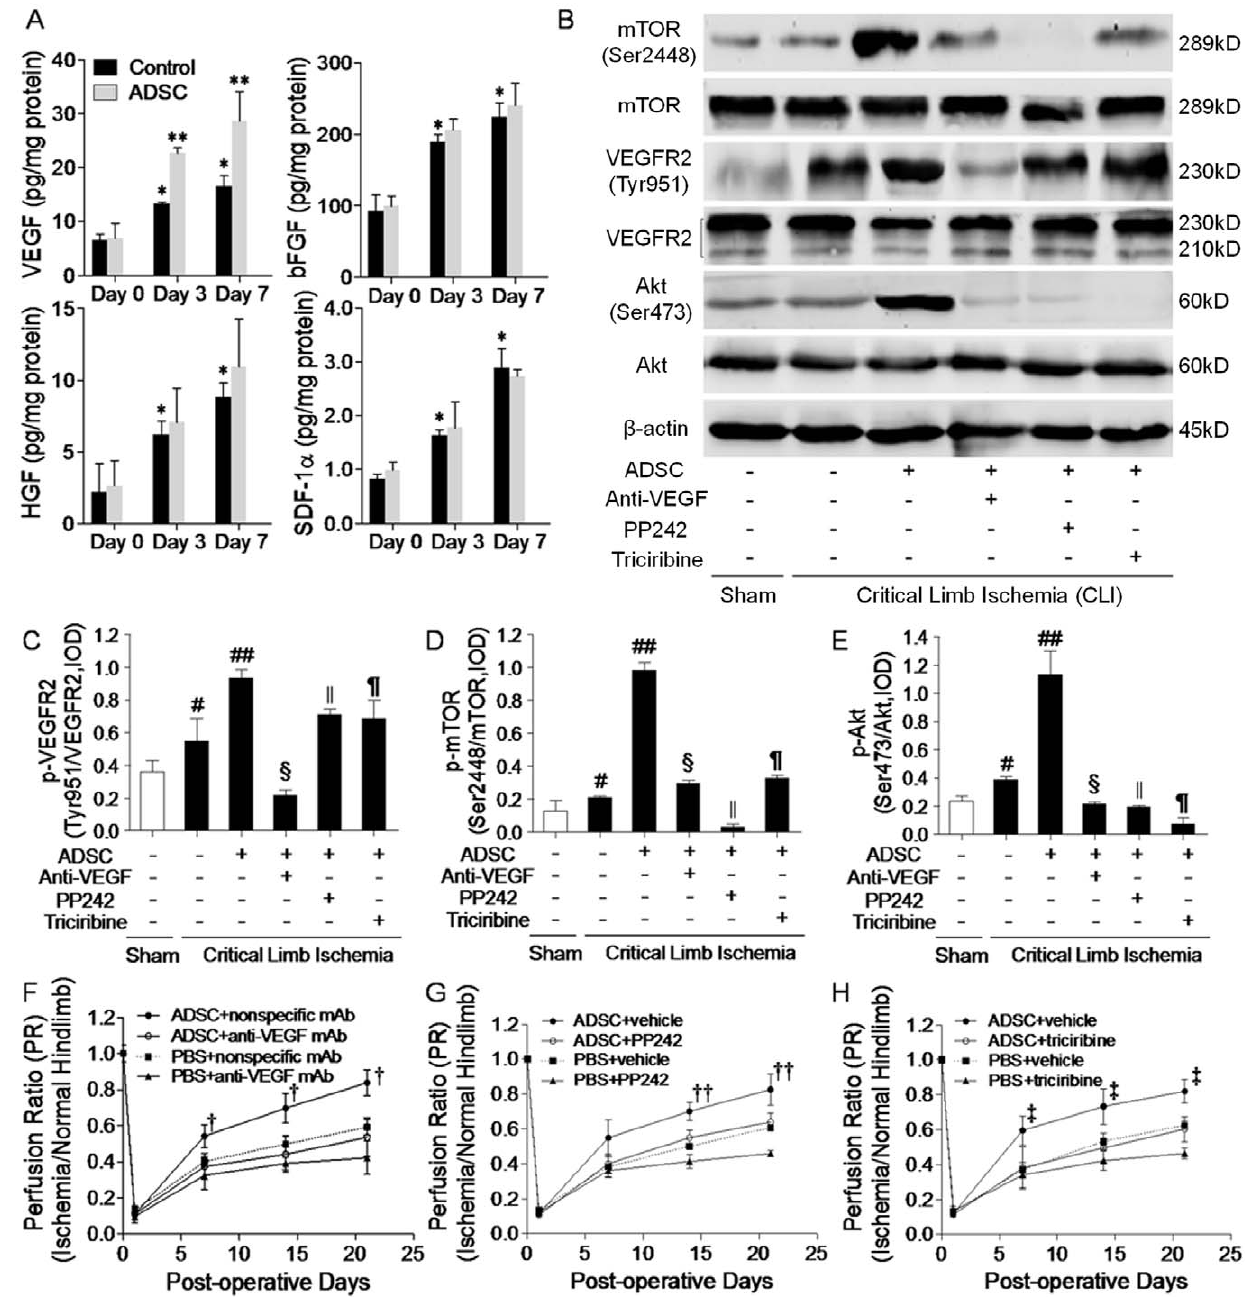
Figure 7. Transplanted mADSCs activated VEGF/mTOR/Akt pathway invivo . Levels of vascular endothelial growth factor (VEGF), basic fibroblast growth factor (bFGF), hepatocyte growth factor (HGF) and stromal cell derived factor-1 a (SDF-1 a ) in PBS or ADSC-treated ischemic hindlimbs on day 0 (baseline), 3 and 7 using ELISA ( a ). Western blot analysis ( b ) of VEGFR2(Tyr951)/VEGFR2 ( c ), mTOR(Ser2448)/mTOR ( d ), Akt(Ser473)/Akt ( e ) and b -actin expression within ischemic hindlimbs on day 7. Protein expression was quantified by the integrated optical density (IOD) ratio of each pair. n=20 for each. LDPI follow-up showed that combined treatment of anti-VEGF monoclonal antibody (mAb) ( f ), PP242 ( g ) or triciribine ( h ) with mADSCs attenuated mADSC-induced blood perfusion restoration, compared with combined treatment of nonspecific IgG or vehicle controls. Error bars: mean 6 SD. * P , 0.05 vs. day 0 within Control group, ** P , 0.05 vs. Control, # P , 0.05 vs. Sham, ## P , 0.001 vs. Control, 1 P , 0.001 vs. ADSC, | P , 0.01 vs. ADSC, " P , 0.01 vs. ADSC, { P , 0.01 vs. ADSC + anti-VEGF mAb, {{ P , 0.001 vs. ADSC + PP242, { P , 0.05 vs. ADSC + triciribine. doi:10.1371/journal.pone.0045621.g007 attenuated mADSCs’ pro-angiogenic function. Intriguingly, acti- VEGFR2/mTOR/Akt activation loop is conceivable in PAD vated mTOR/Akt can further promote VEGF expression in a models, with transplanted mADSCs serving to amplify the loop to facilitate angiogenesis. feedforward manner [22,37]. Overall, a sequential VEGF/